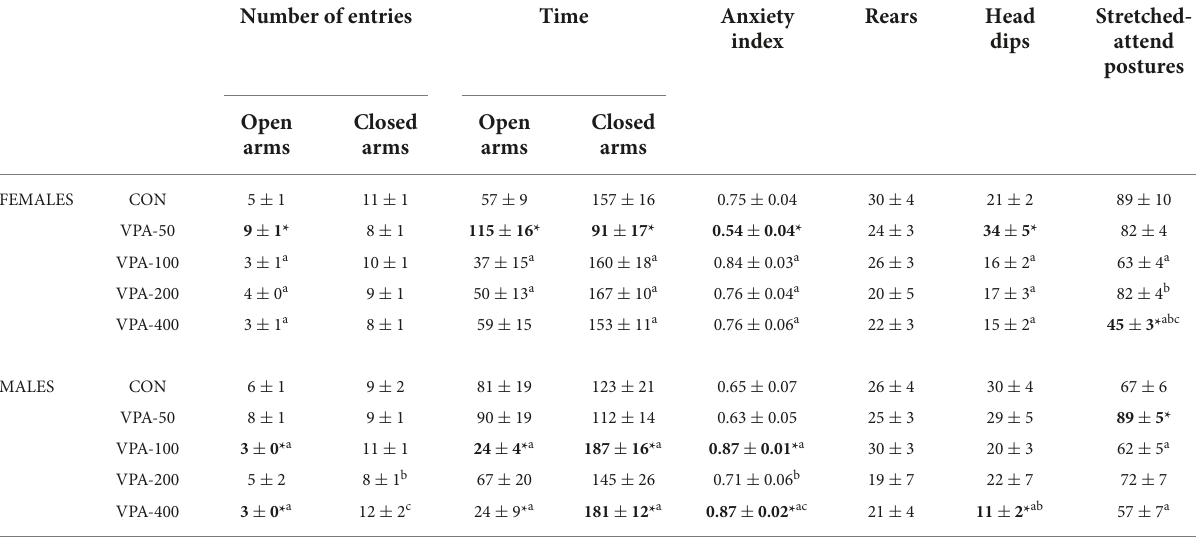
Rears Head Stretched- index dips attend postures